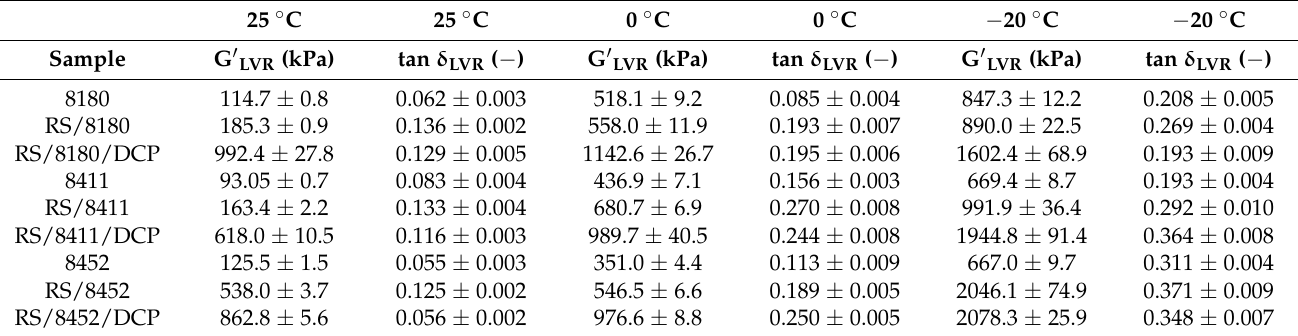
Table 3. The storage shear modulus G (cid:48) and loss tan δ measured for the linear viscoelastic region at various